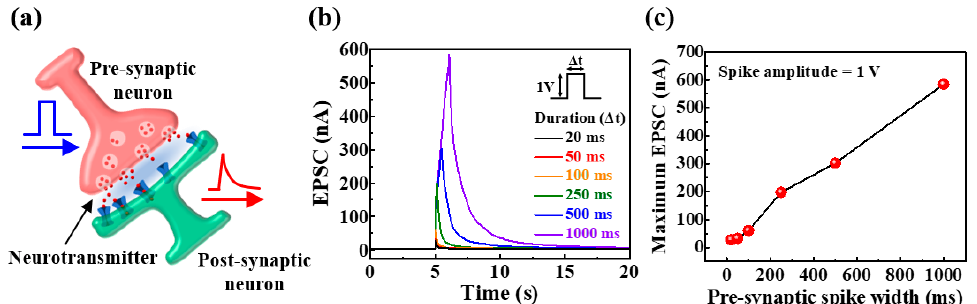
Figure 3. ( a ) Schematic of biological neuron and synapse; ( b ) excitatory post-synaptic currents (EPSCs) generated by pre-synaptic single-spike (1 V amplitude) for various durations (20 to 1000 ms); and ( c ) maximum EPSC as a function of pre-synaptic pulse duration.